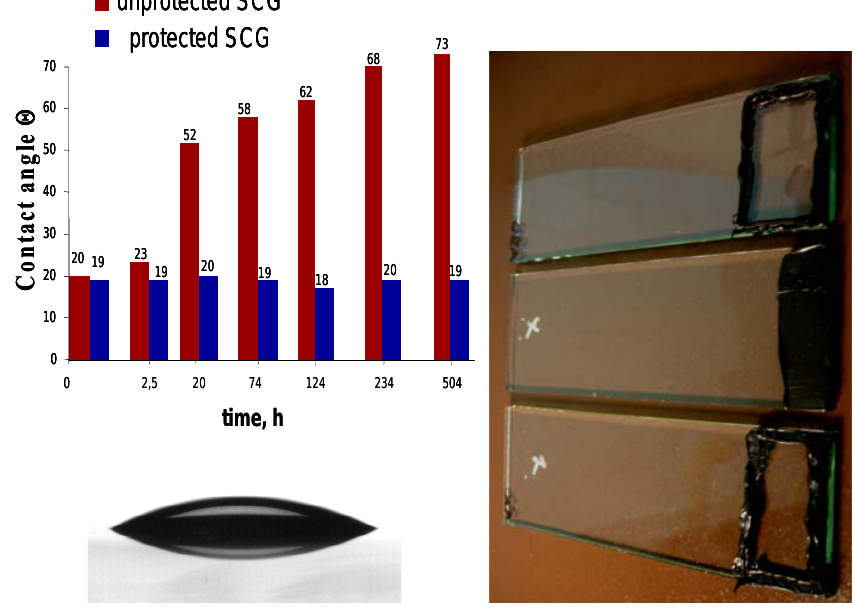
Figure 3. Effect of the sealant on the contact angle of a water droplet measured on protected and unprotected SCG as a function on time. (The origin denoted the time at which the silicone seal was applied.) On the right are photographs of the SCG samples wherein the sealants geometry (black) was varied. Below a side view of a water droplet on protected SCG is